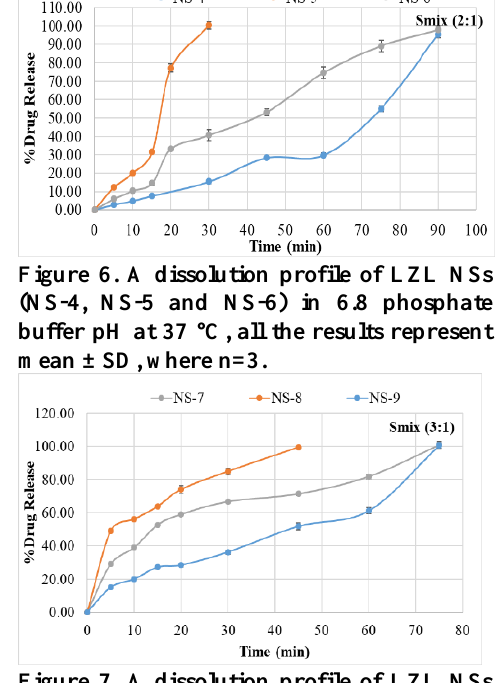
Figure 7. A dissolution profile of LZL NSs (NS-7, NS-8 and NS-9) in 900 ml of 6.8 pH dissolution medium at 37 °C, all the results represent mean ± SD, where